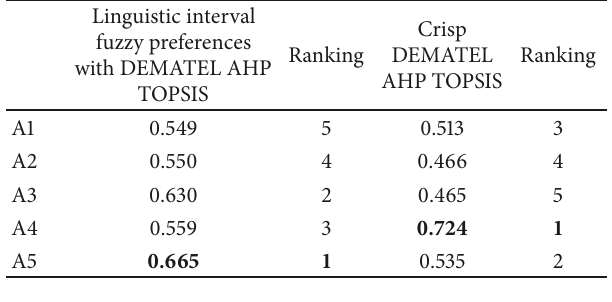
Table8:Alternativefinalpreferencescoresusinglinguisticandcrisp terms [20].